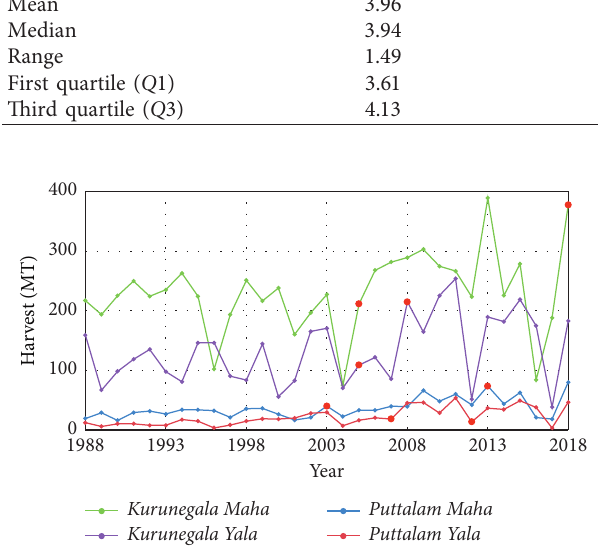
Figure 1: Variation of rice harvest over three decades